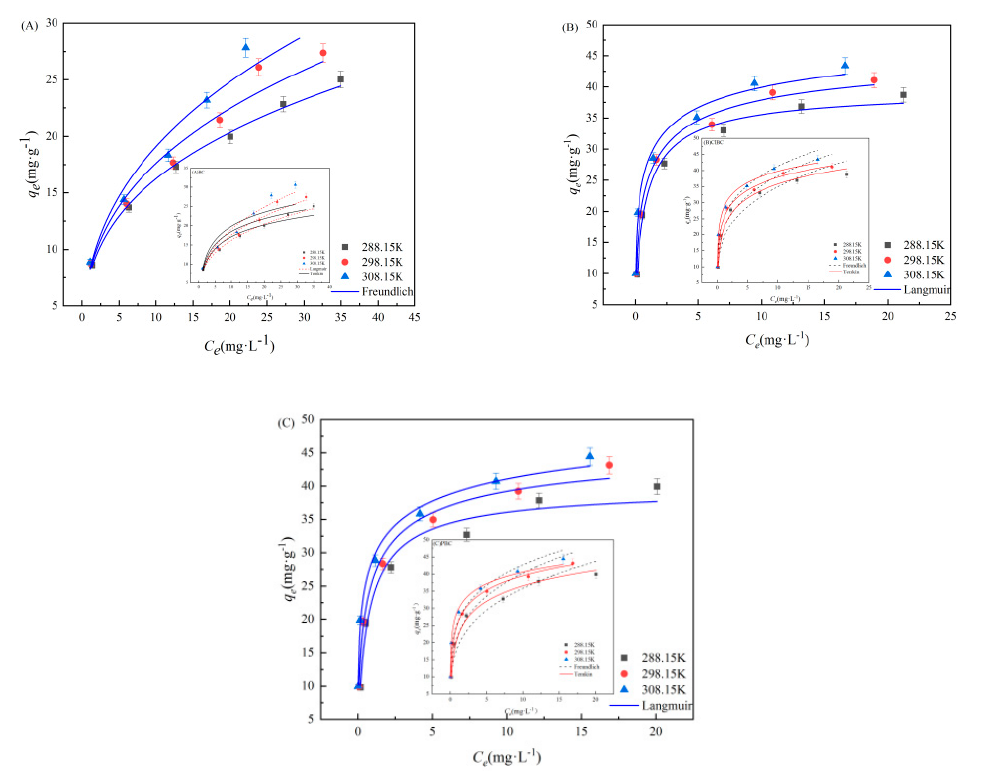
Figure 5. Langmuir, Freundlich and Temkin model for SMX adsorption on ( A ) BC, ( B ) ClBC and ( C ) PBC.